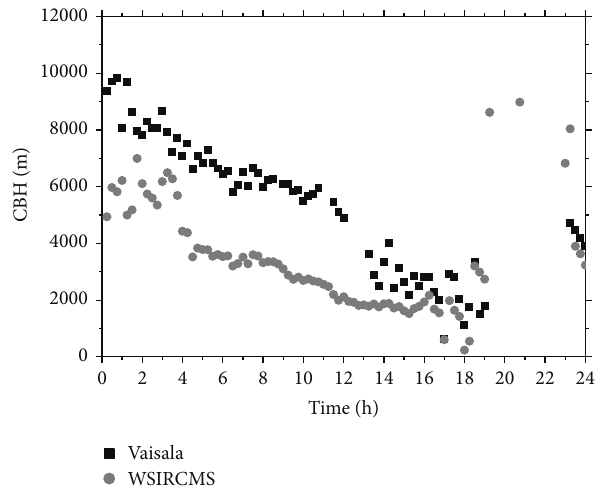
Figure 8: The 16 November 2011 case: CBH values as determined by WSIRCMS (grey circle) and Vaisala CL51 (black square).